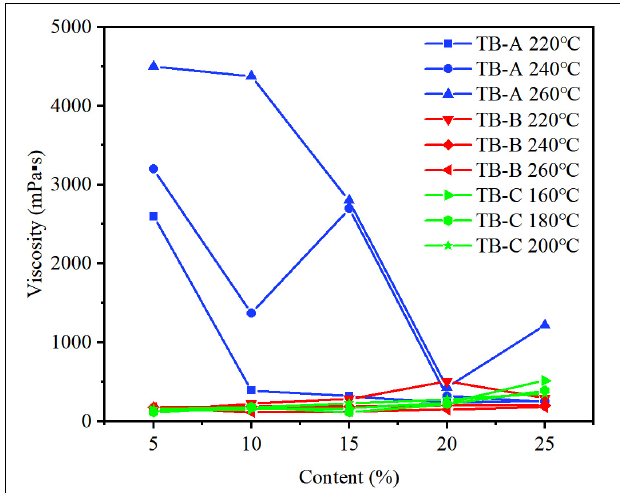
FIGURE 9 | 177 ◦ C viscosity of TB